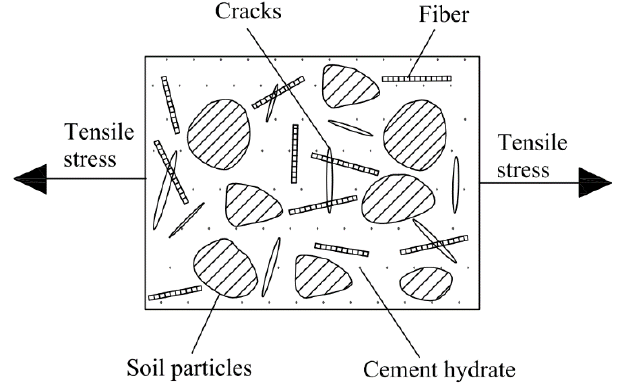
Figure 11. Model of fibers restraining crack formation in